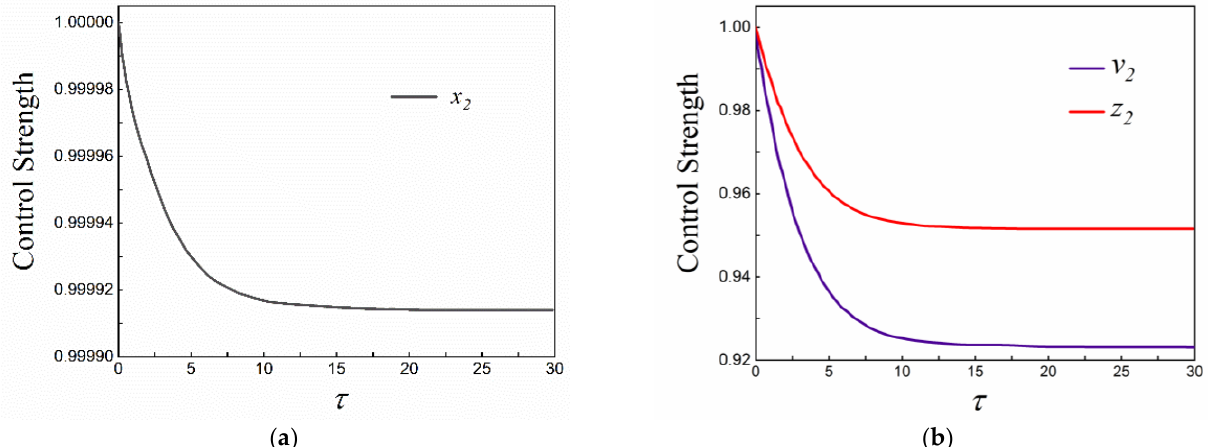
Figure 17. The evolution of the control strengths in time: ( a ) The variation of the x 2 ( τ ) control strength; ( b ) the stabilization values of the v 2 ( τ ) and z 2 ( τ